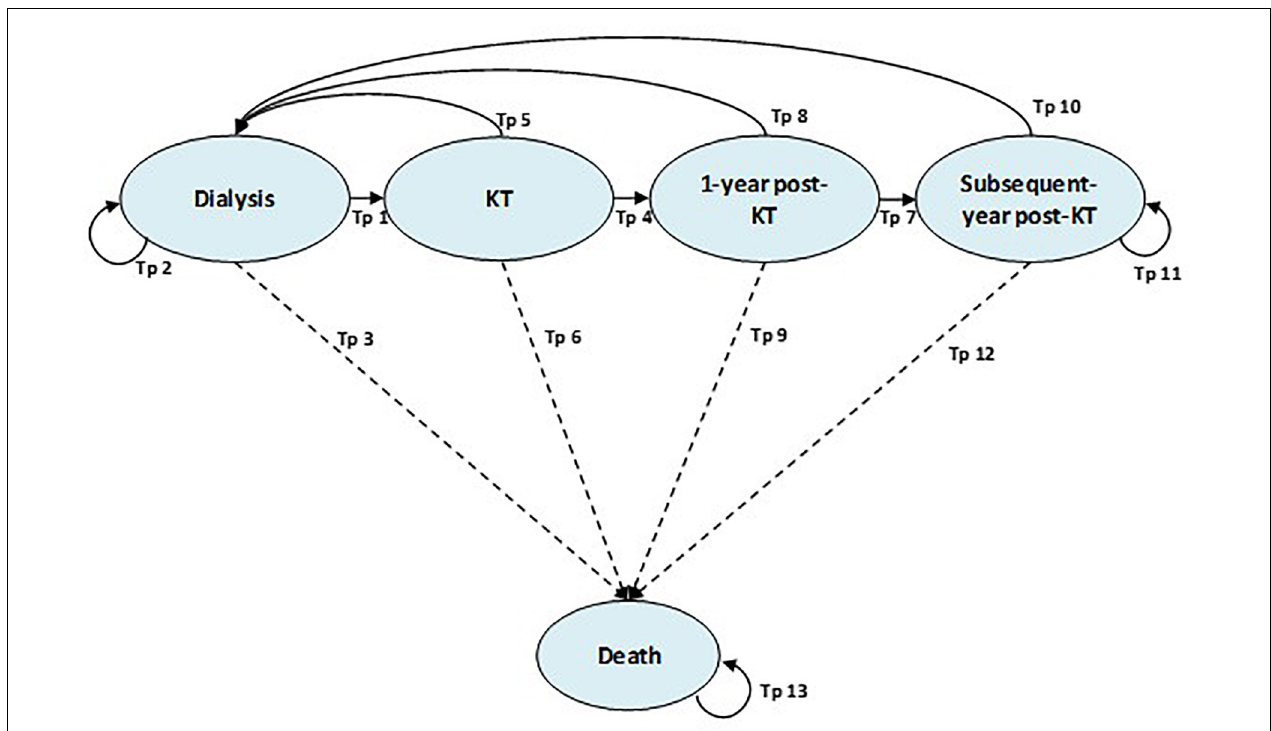
FIGURE 1 | Markov model. KT, kidney transplantation; Tp, transitional